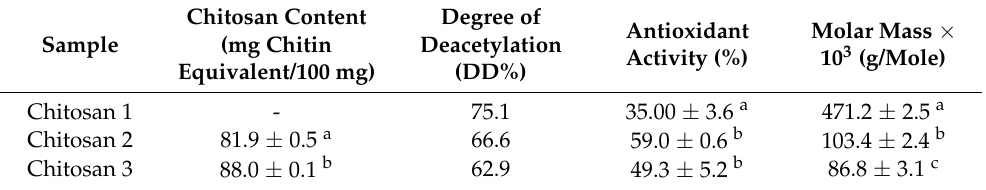
Table 1. Properties of obtained chitosan samples. Chitosan 1 refers to the chitosan produced from commercial chitin, Chitosan 2 to the chitosan produced from chitin isolated with the chemical method from cricket flour, and Chitosan 3 to the chitosan produced from the chitinous material isolated by the biological method from cricket flour. Data are presented as mean ± SD. Superscript letters (a, b, c) indicate significant differences ( p < 0.05) between means of the same property of different chitosan